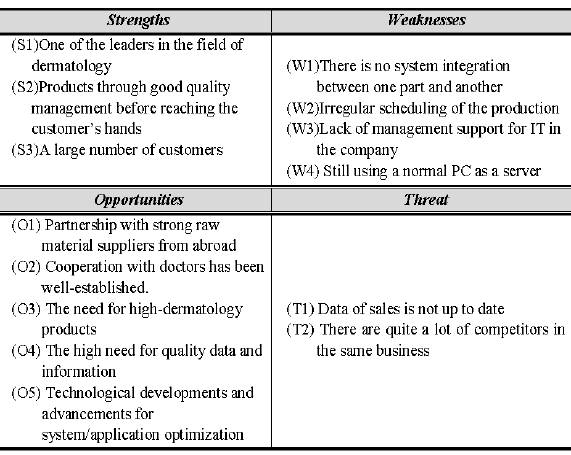
Figure 4: SWOT Analysis of Pharmaceutical Company